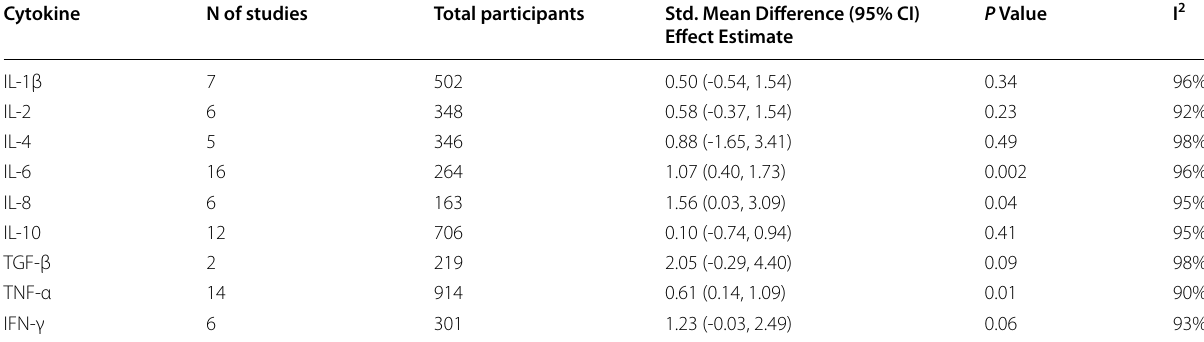
Abbreviations : CI Confidence interval, I 2 Measure of heterogeneity, IL-1β Interleukin-1β, IL- , Interleukin-2, IL-6 Interleukin-6, IL-4 Interleukin-4, IL-8 Interleukin-8, IL-10 Interleukin-10, TGF-β Transforming growth factor β, TNF-α Tumor necrosis factor alpha, IFN-γ Interferon gamma